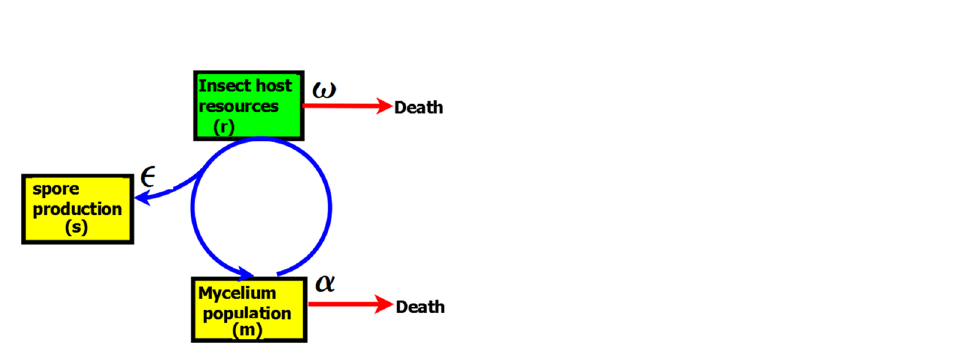
Table 2. List and definition of model parameters.